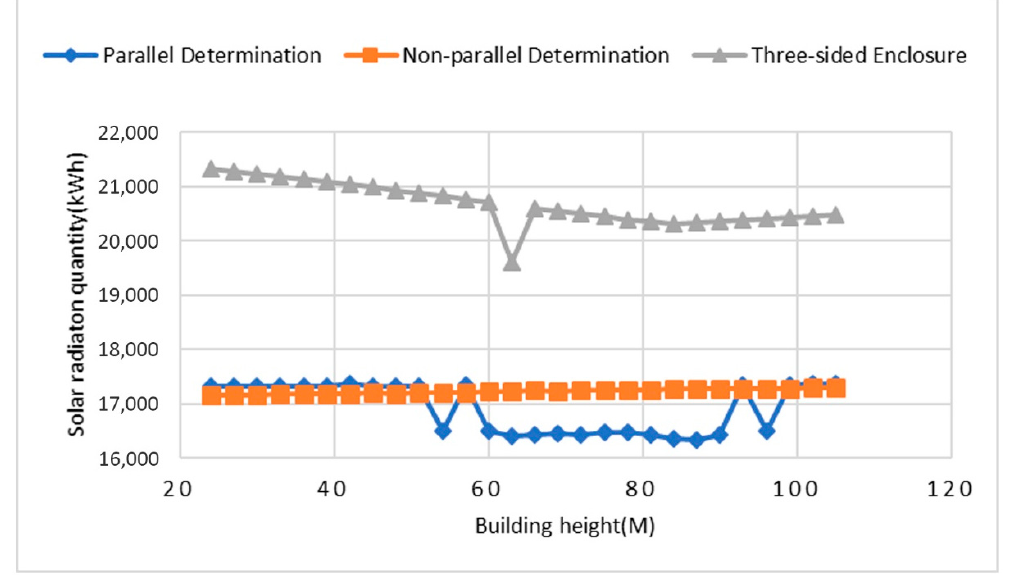
Figure 9. Relationship between building height and solar radiation quantity.